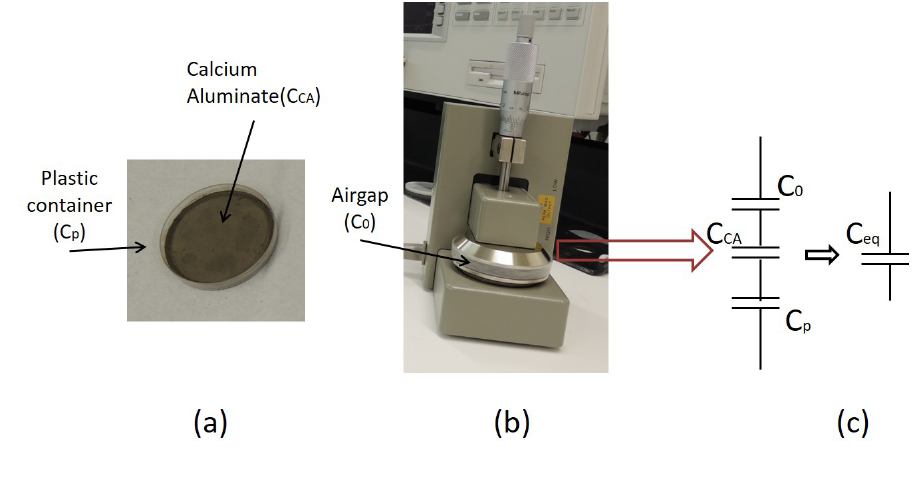
Figure 3. ( a ) CA sample in the container; ( b ) Sample located in the Dielectric text fixture 16451B; ( c ) Equivalent circuit ( C e ).